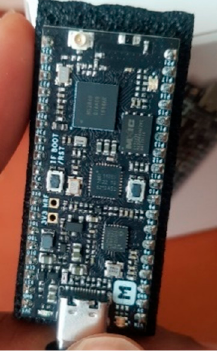
Figure 9. A nRF52840 ‐ MDK development kit used to configure the Thread network during the research [77].